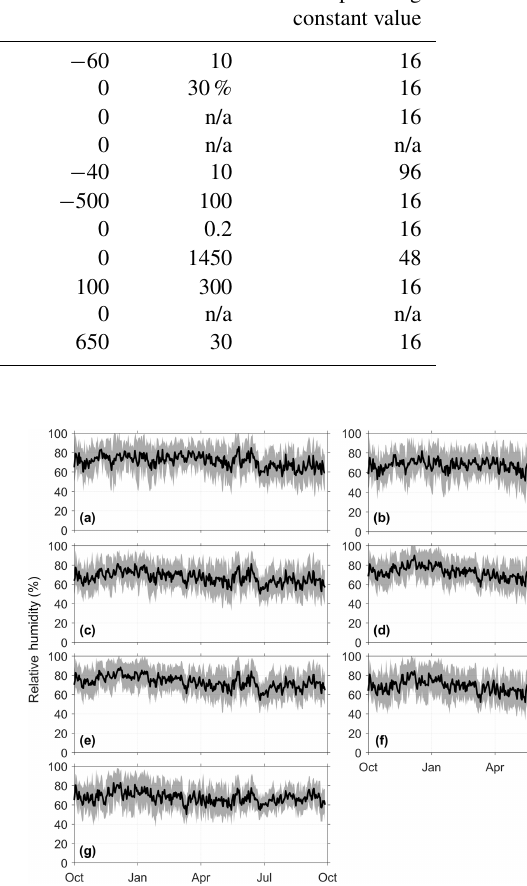
Figure 4. Annual mean daily air temperature for 11 water years from 1 October 2005 to 30 September 2016 at MCRB stations: (a) Centennial Ridge, (b) Fisera Ridge, (c) Vista View, (d) Upper Clearing, (e) Upper Forest, (f) Level Forest, and (g) Hay Meadow. The line represents the annual mean and the shaded area represents the standard deviation of the 11-year daily air temperature.